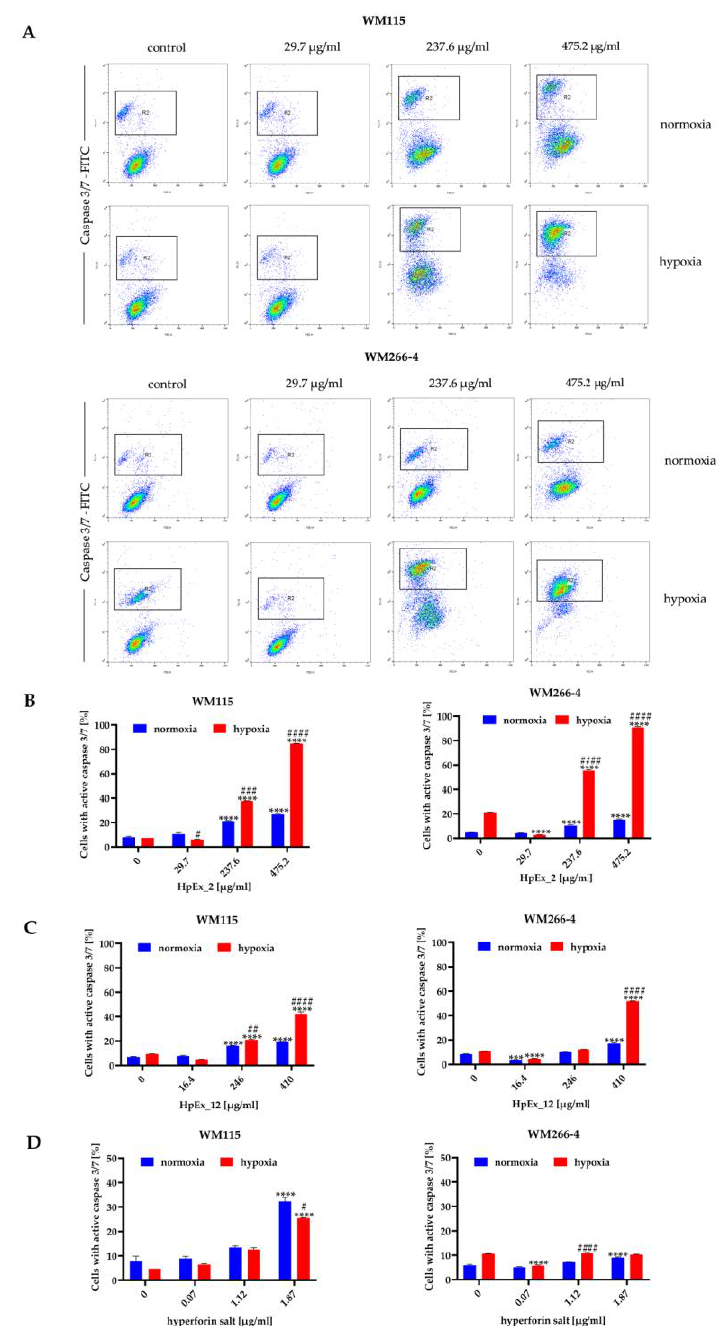
Figure 3. Detection of activated caspases 3 and 7 in apoptotic cells of the WM115 and WM266-4 melanoma lines treated with ethanolic extracts of Hypericum perforatum and hyperforin salt, cul-